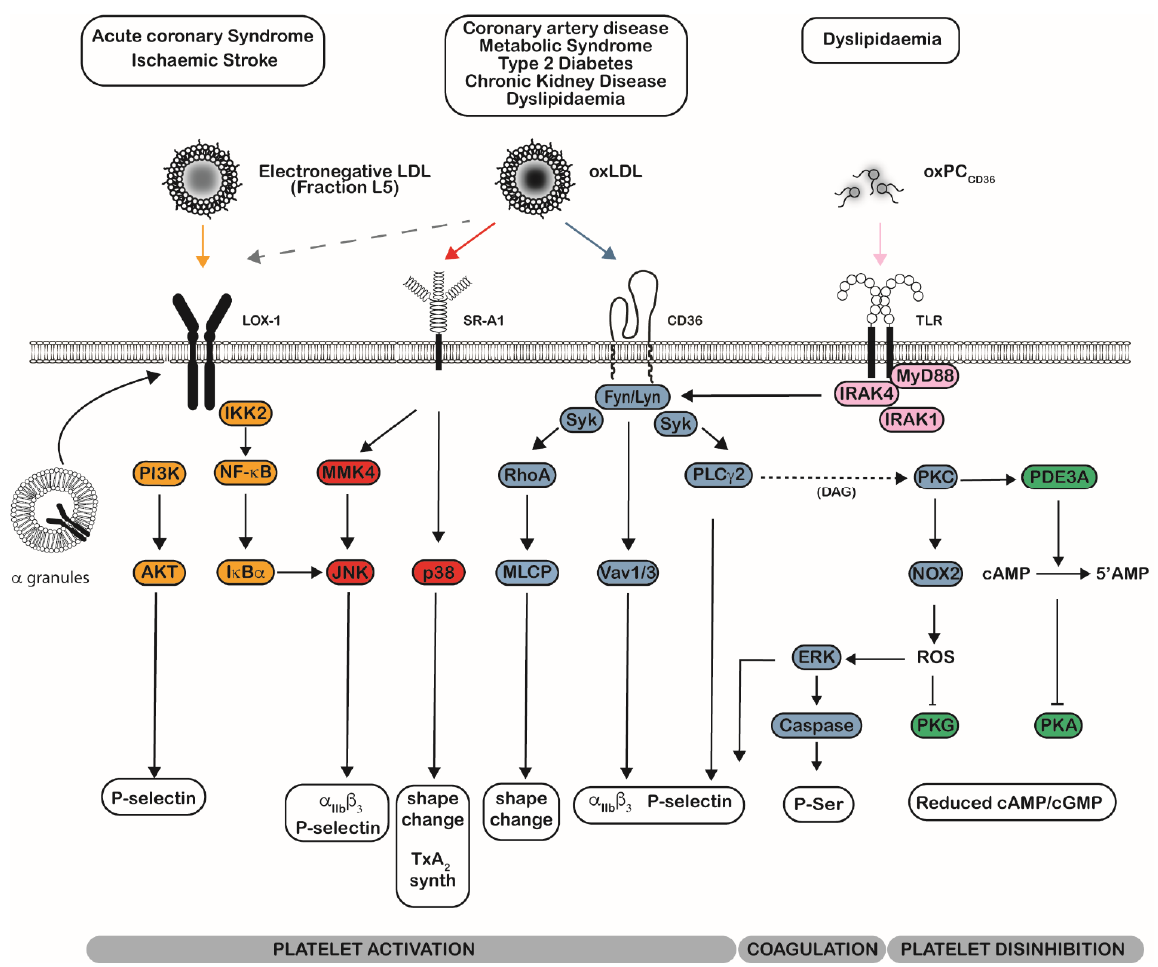
Figure 1. Major signalling events downstream platelet scavenger receptors induced by oxidatively modified LDL. Platelets are exposed to different types of oxidatively modified LDL, which interact with distinct pattern recognition receptors on their surface. Given that these particles have a complex and varied chemical composition, there is potential for particular LDL species to interact with different receptors. OxLDL has been shown to interact with CD36, SRA1, and potentially LOX-1. In contrast, electronegative LDL (fraction L5) has currently only been shown to interact with LOX-1. TLR2 has not been shown to bind with oxLDL but does interact with specific oxidised phospholipids that are known to be present in oxLDL (oxPC CD36 ). LOX-1 is located in the alpha granules of resting platelets and recruited to the platelet surface upon platelet activation. Once at the platelet surface, LOX-1 can bind electronegative LDL to stimulate signalling events (yellow) through PI3K and JNK to increase P-selectin expression and integrin a IIb b 3 activation. SR-A1 binds oxLDL to initiate signalling through JNK and p38 (red), which can drive P-selectin expression, a IIb b 3 activation, shape change, and TxA 2 . CD36 is constitutively associated with the Src family kinases Fyn and Lyn and, once ligated by oxLDL, incites a multitude of pathways (Blue). These drive shape change through RhoA and MLCP, P-selectin expression, and a IIb b 3 activation through Vav1/3 and PLCg2. This pathway also leads to the activation of a PKC isoform, which is critical to the control of membrane phospholipids and inhibitory signalling (green). PKC induces the ROS generation through NOX2, which activates both ERK and phosphatidyl serine exposure, as well as the inhibition of PKG. PKC also activates PDE3A, which reduces cAMP concentrations and the activation of PKA. TLR2 does not bind oxLDL, but interaction with oxidised phospholipids leads to the MyD88-mediated activation of tyrosine kinase signalling, P-selectin expression, and a IIb b 3 activation. Abbreviations: Phosphoinositide 3-kinase (PI3K), c-Jun N-terminal kinase (JNK), Myosin light chain phosphatase (MLCP), extracellular-signal regulated kinases (ERK), Protein kinase G (PKG), Protein kinase A (PKA), Protein kinase C (PKC), Phospholipase C gamma 2 (PLCg2), Vav1/3, NADPH Oxidase 2 (NOX2), p38.